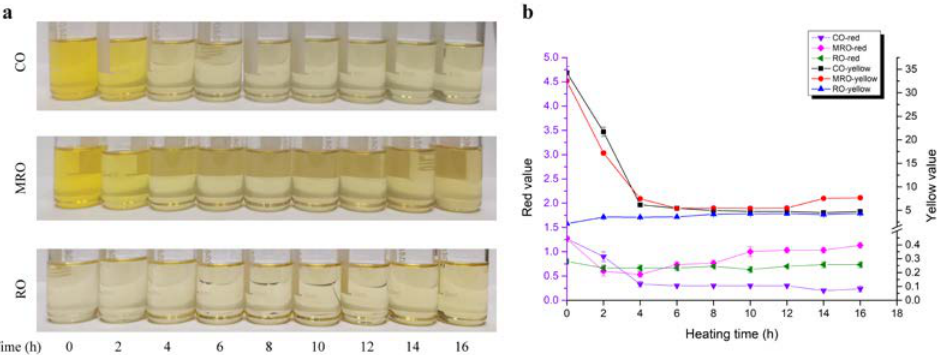
Figure 1. Changes in color in three kinds of camellia oil during heating. CO: crude oil; MRO: moderately refined oil; RO: refined oil. ( a ) Pictures of camellia oil samples during heating. ( b ) Changes in the red and yellow values of camellia oil samples during heating.